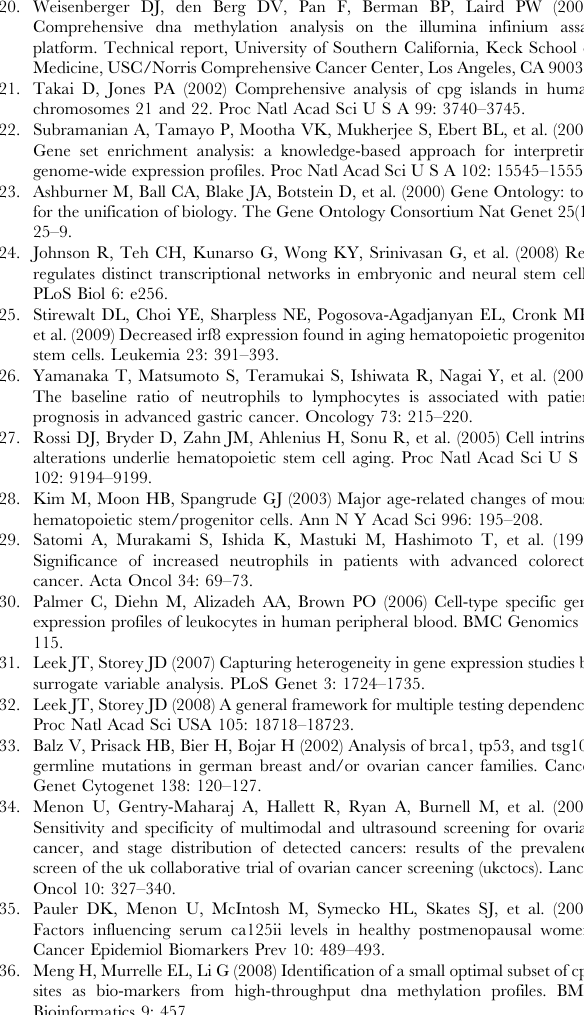
Table S5 Discriminatory CpGs between postreatment samples without active disease and healthy controls.